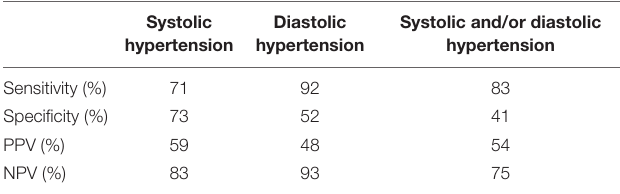
TABLE 2 | Accuracy metrics of daytime smartwatch measures for the blood pressure cut-off of 135/85